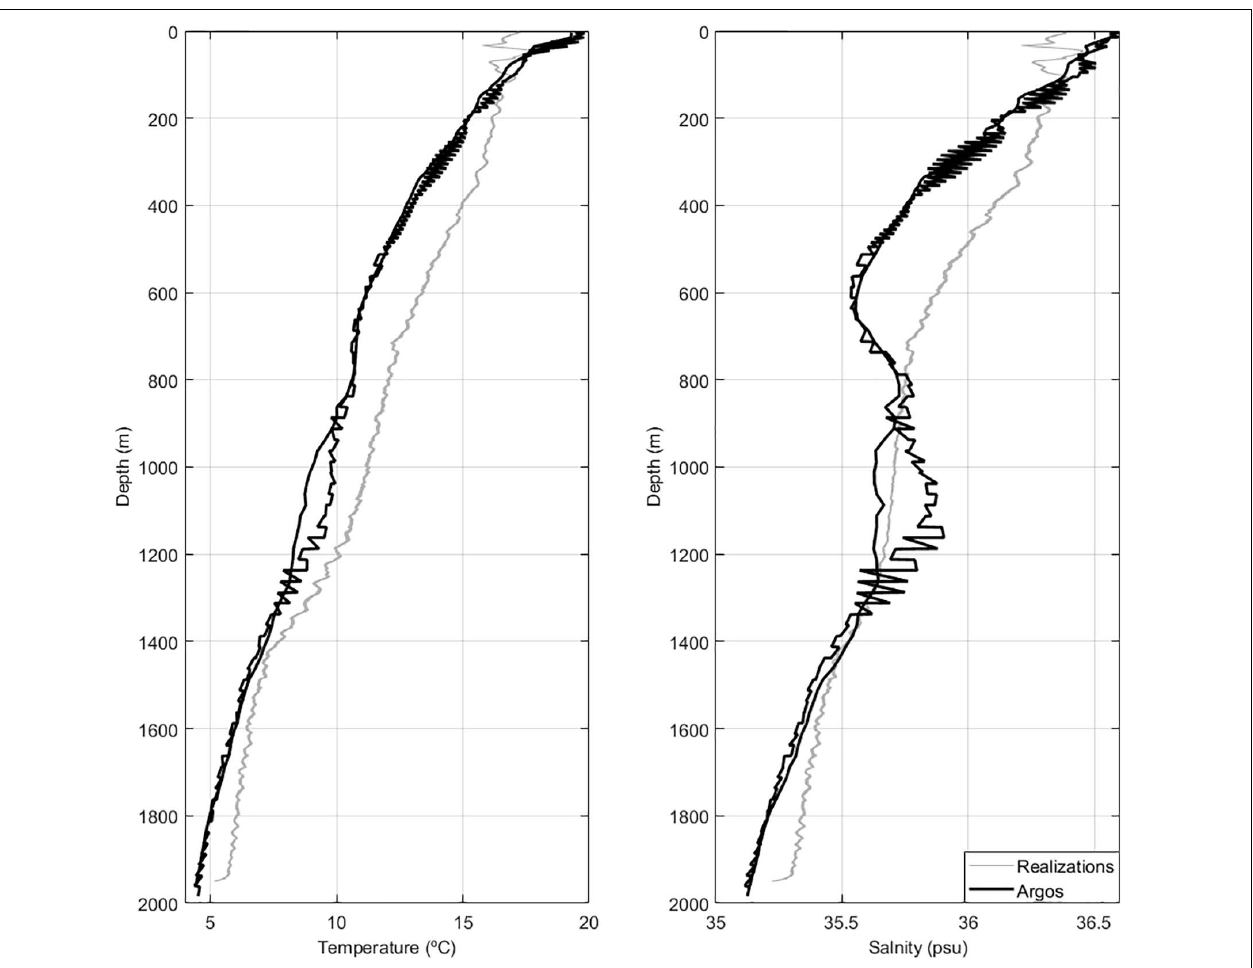
FIGURE 14 | Comparison between the temperature and salinity vertical profiles measured at the ARGO floats locations ( Figure 3 ) and the average vertical profile of temperature and salinity for all the thirty-two realizations generated during the last iteration of the geostatistical